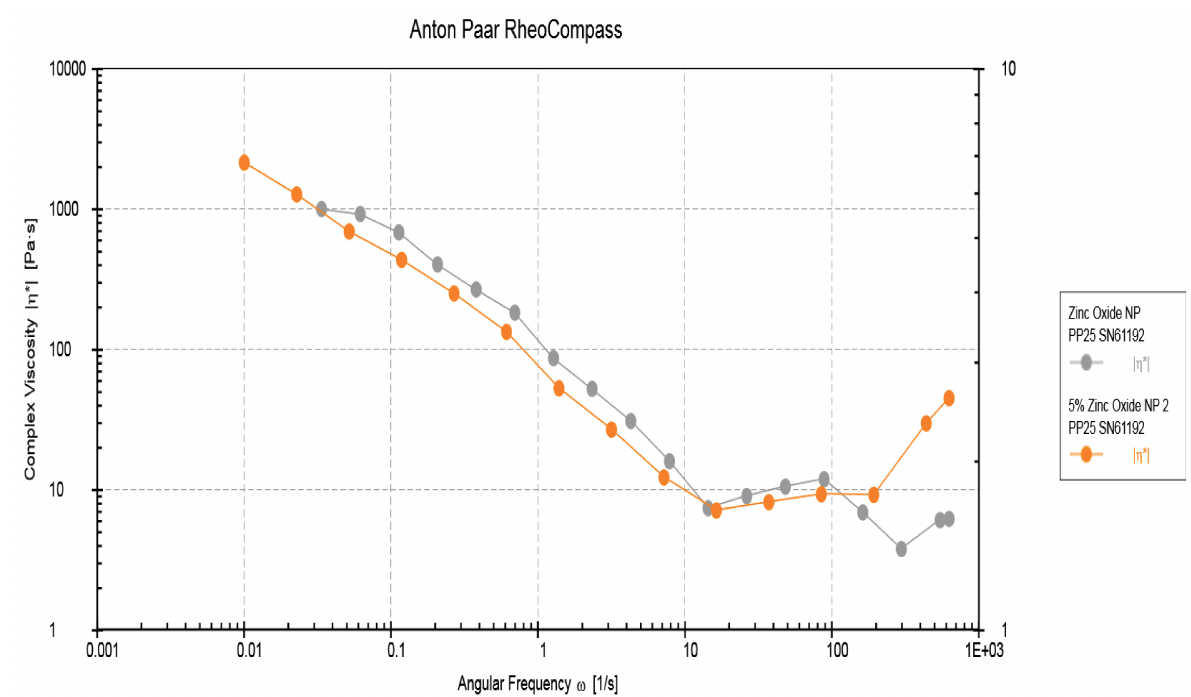
Figure 5. Rheological properties of the experimental control (EA-0% rGO) and rGO 5% adhesives. Complex viscosity vs. angular frequency at 0.001 to 1000 rads/s.